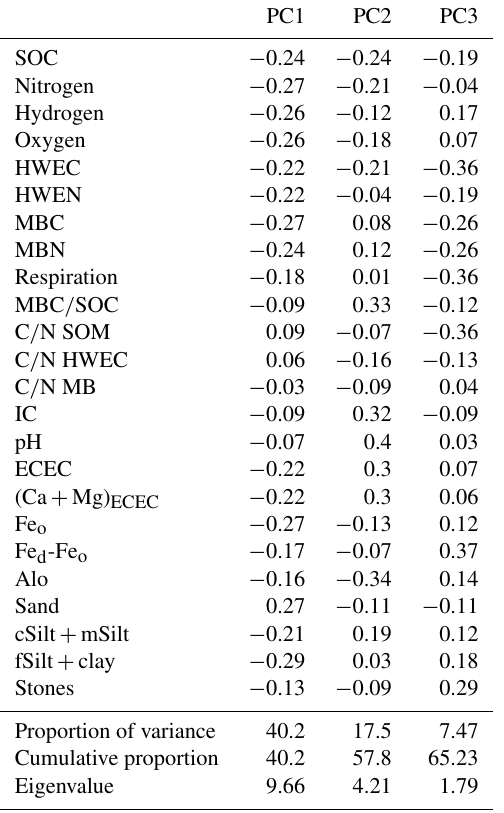
Table 2. Loadings of the variables on the first three principal com-